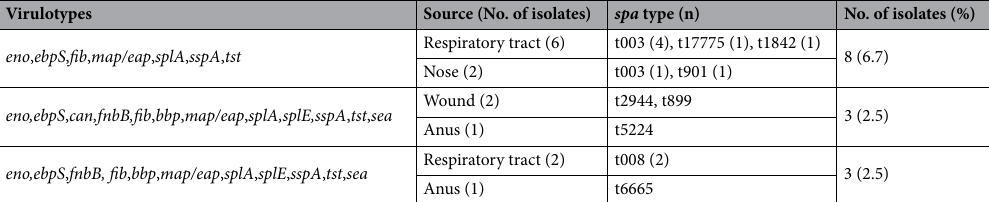
Table 2. The most frequent virulotypes in MRSA isolates from different clinical specimens.